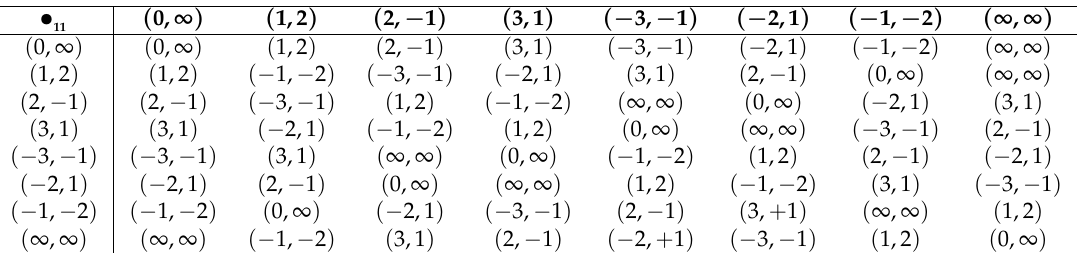
Table 1. Conic group